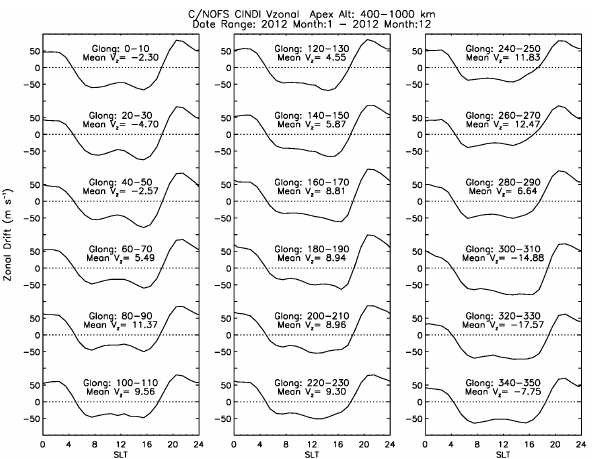
433 Figure 3. Line plots of CINDI zonal ion drift versus SLT for selected longitudes 434 during 2012 in the 400–1000 km apex altitude region (the same data set as Figure 435 Fig. 3. Line plots of CINDI zonal ion drift versus SLT for selected 2). The mean zonal drift averaged over all 24 hours of SLT is given for each 436 longitudes during 2012 in the 400–1000km apex altitude region longitude. 437 (the same data set as Fig. 2). The mean zonal drift averaged over all 24h of SLT is given for each longitude.